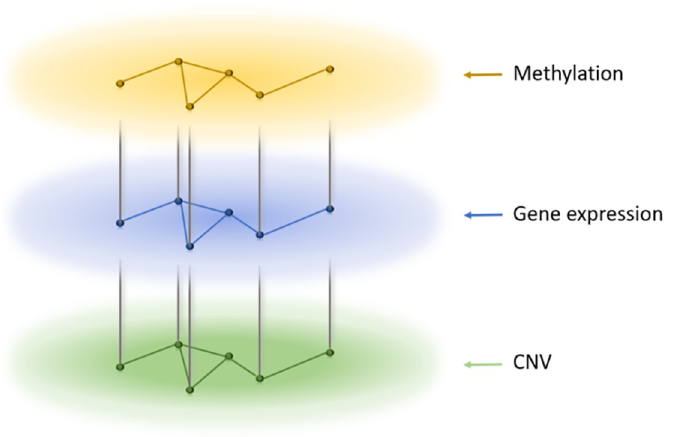
Fig 1. Graph structure for the TCGA breast cancer